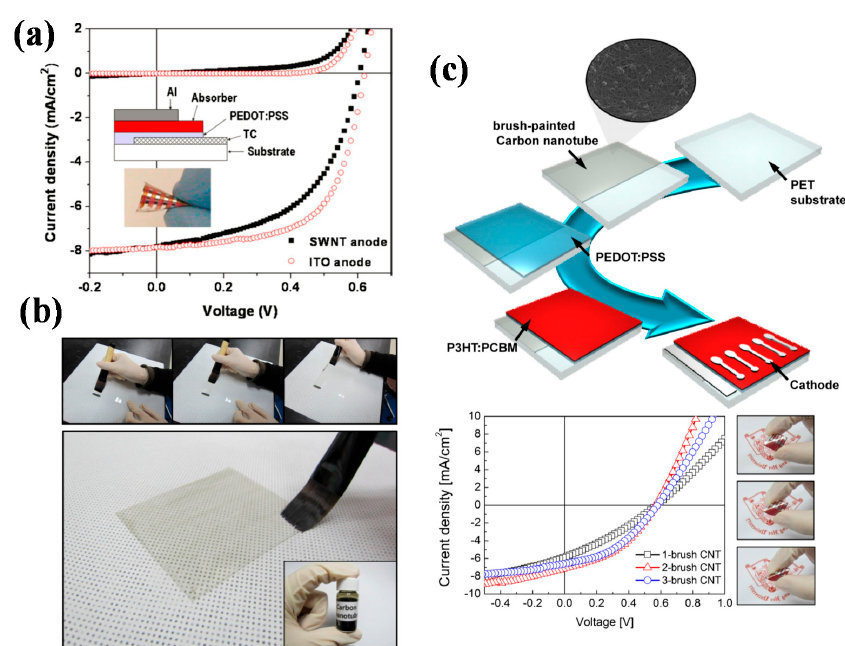
Figure 1. ( a ) Current density–voltage (J–V) characteristics of P3HT:PCBM devices under AM1.5G conditions using indium tin oxide (ITO) on glass and flexible SWNTs on PET as the anodes, respectively. Reprinted from [40], with the permission of AIP Publishing; ( b ) Picture of brush printing process (upper panels) to fabricate transparent carbon nanotubes (CNT) network electrodes and transparent 3-brush CNT electrode; ( c ) Schematic of the fabrication process for bulk-heterojunction OSCs on a CNT network electrode and J–V curves of FOSCs (flexible organic solar cells) fabricated on the CNT electrodes where the right panel shows the flexibility of the FOSCs with a brush-painted CNT network electrode. Reprinted from [41], Copyright 2014, with permission from Elsevier.